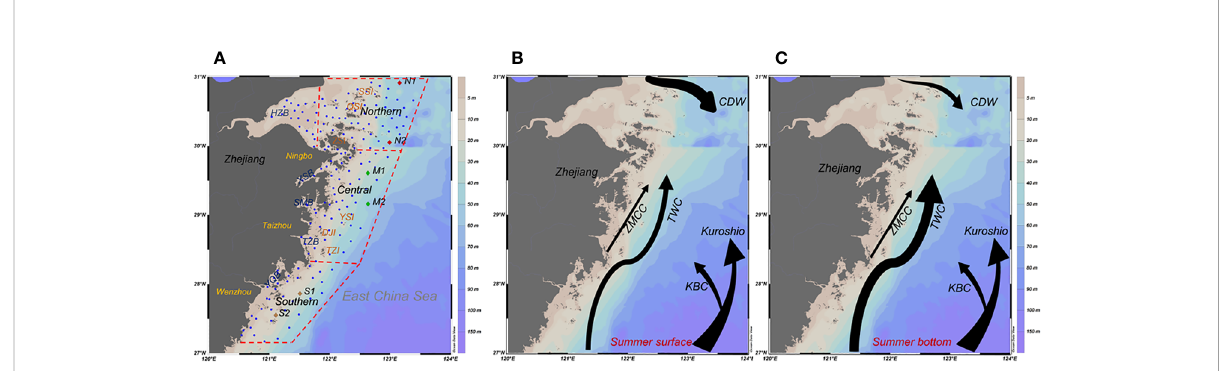
FIGURE 1 Sampling sites (blue dots) (A) and currents (B , C) in the Zhejiang coastal area. The current images (B , C) were changed and redrawn based on Zuo et al., 2019. The name of the bays and islands were all abbreviated, where HZB is Hangzhou Bay, XSH is Xiangshan Harbor, SMB is Sanmen Bay, TZB is Taizhou Bay, YQB is Yueqing Bay, ZSI is Zhoushan Archipelago, SSI is Shengsi Islands, QSI is Qushan Island, YSI is Yushan Islands, DJI is Dongji Islands, and TZI is Taizhou